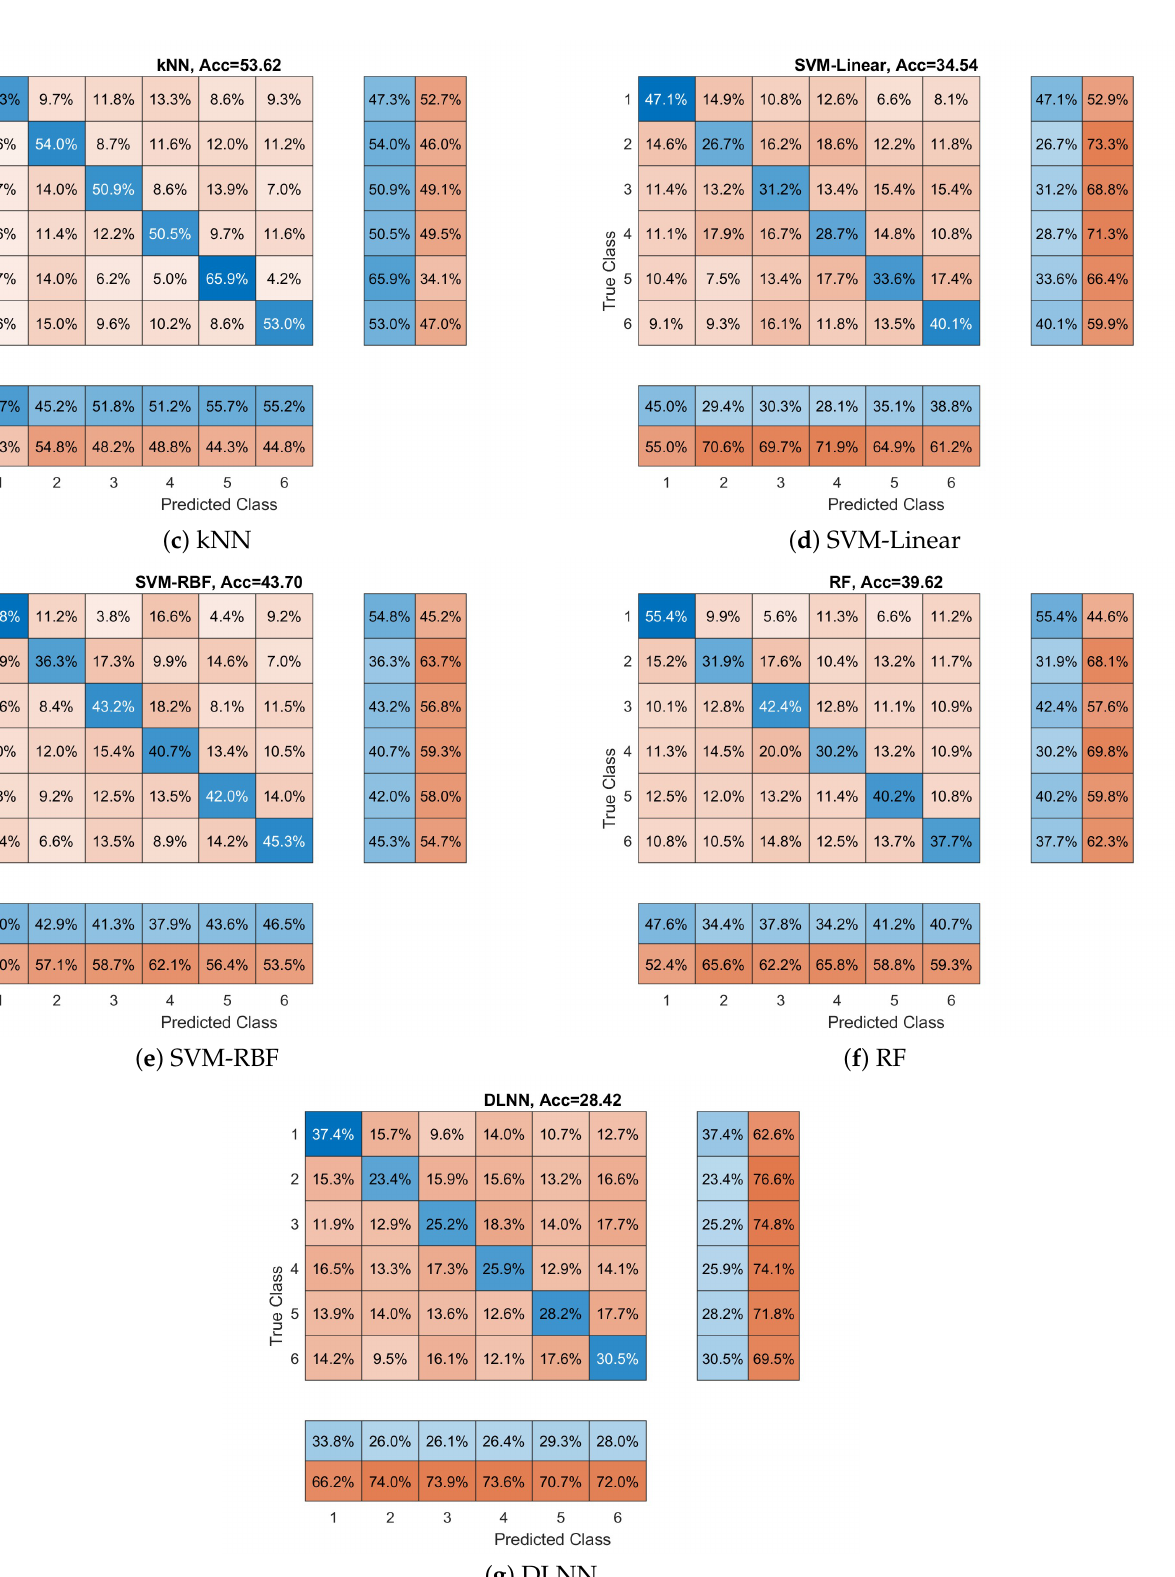
Figure 2. Overall accuracy and confusion matrices for each method with respect to products’ prefer- ences. Each matrix provides the overall performance of each classifier with respect to each class (in our case, product’s preferences). Furthermore, class-wise precision (last two separated columns on the right) and class-wise recall (last two separated rows on the bottom) are